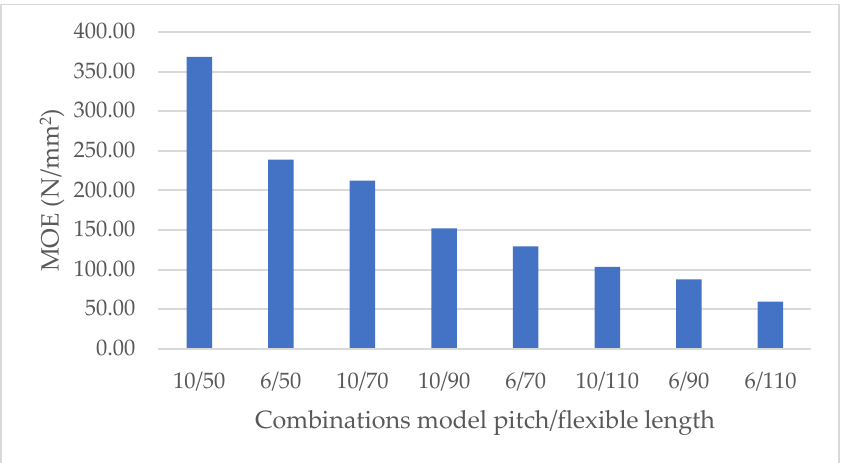
Figure 8. Mean values of the MOE for combinations of model pitch and flexible length.